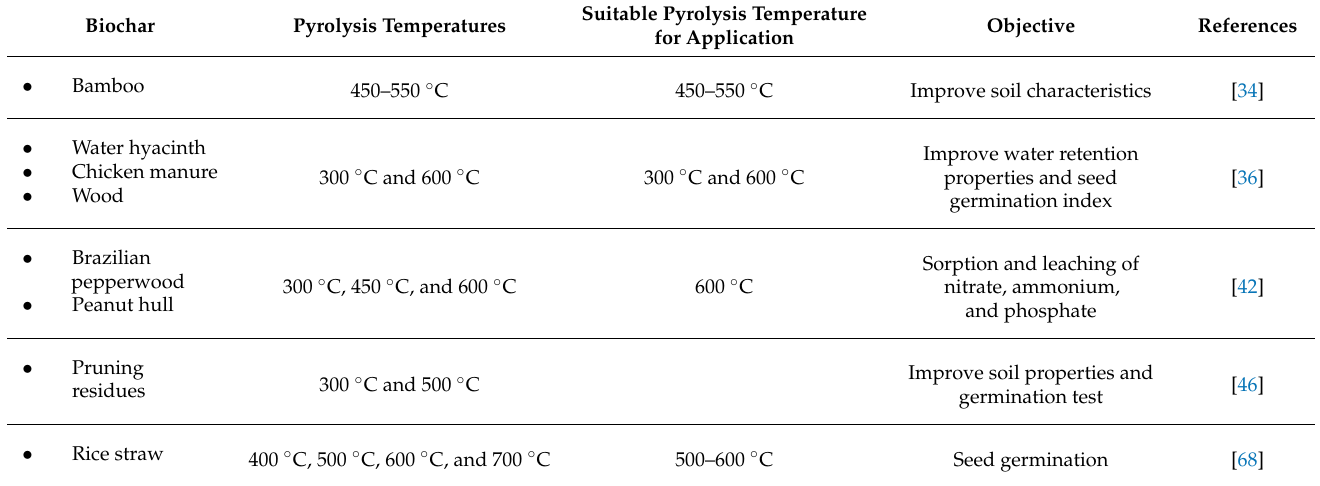
Table 4. Applying biochar as a soil